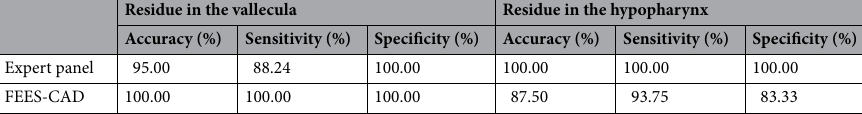
Table 5. Comparison between FEES-CAD and expert panel on residue in the vallecula and residue in the hypopharynx